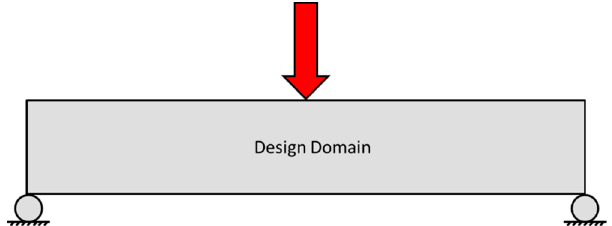
Figure 3. Messerschimitt–Bölkow–Blohm (MBB) beam design space with boundary conditions and applied load.